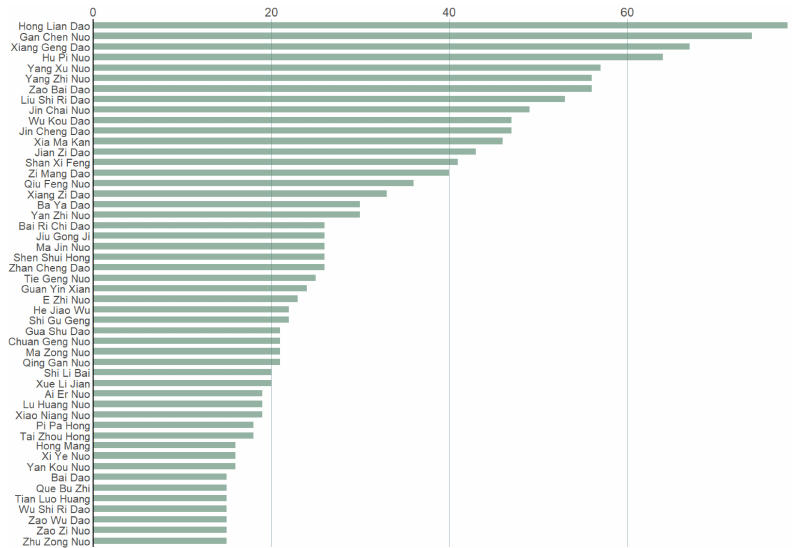
Figure 2. Top 50 rice cultivars with the highest occurrences in our dataset. x -axis from top to bottom corresponds to the top 1–50 cultivars in a descending order. y -axis corresponds to the number of records of each cultivar in our dataset.